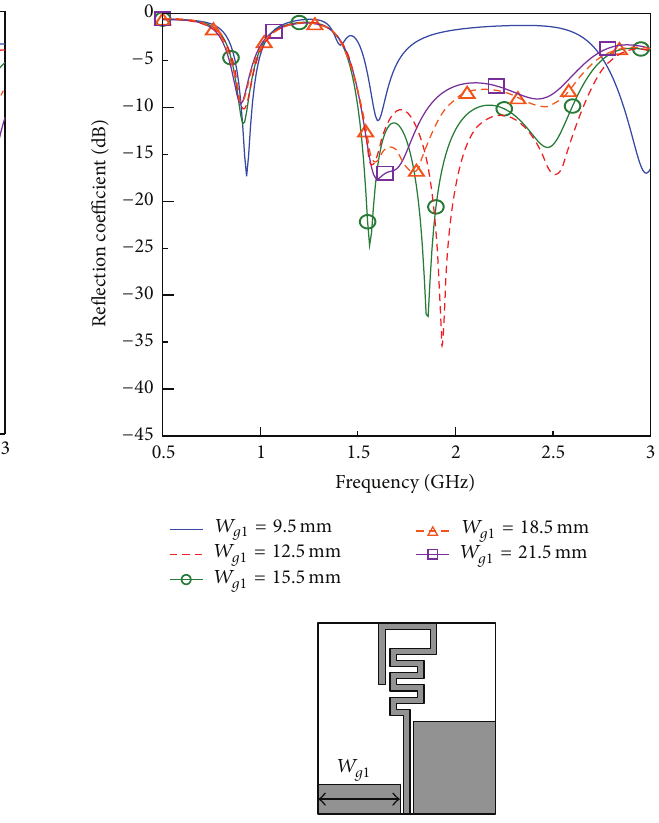
Figure 4: Comparison of simulated reflection coefficients of the proposed antenna with various 𝐻 𝑔1 .